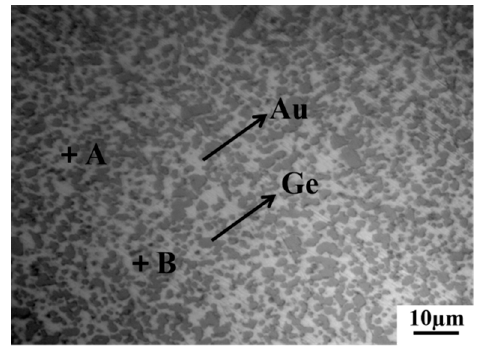
Figure 5. Optical microstructure of Au-12Ge solder. Table 1. The energy-dispersive spectrometer (EDS) results of Figure 5.